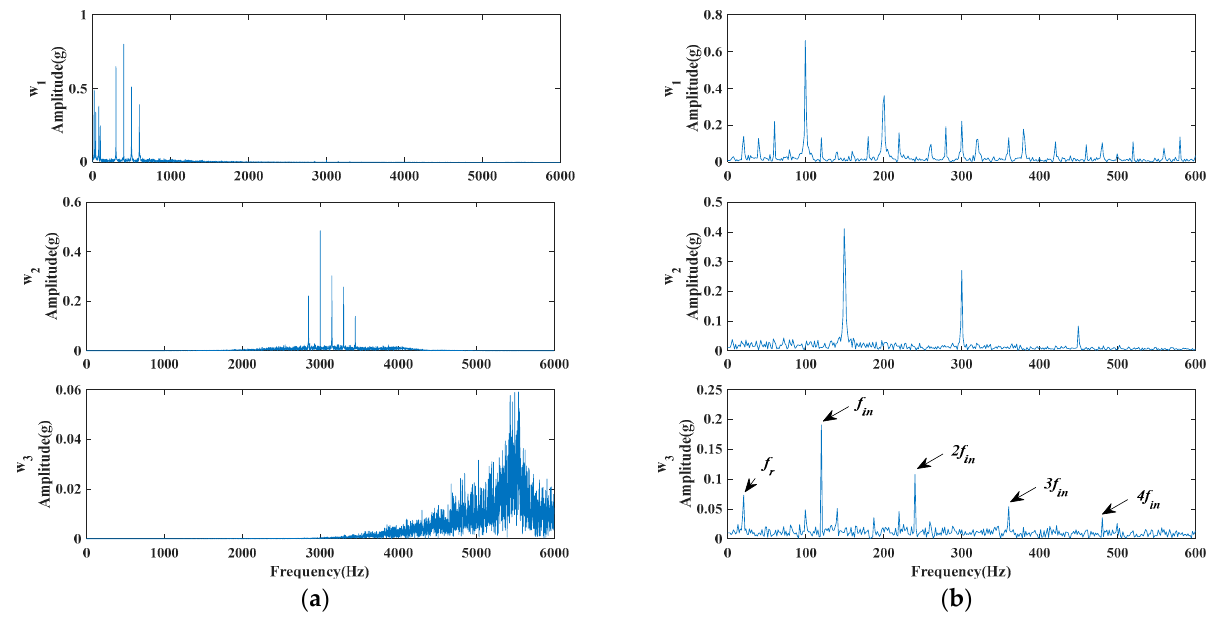
Figure 11. Analysis results of each mode of the simulated inner race fault signal: ( a ) frequency spectrum; ( b ) envelope